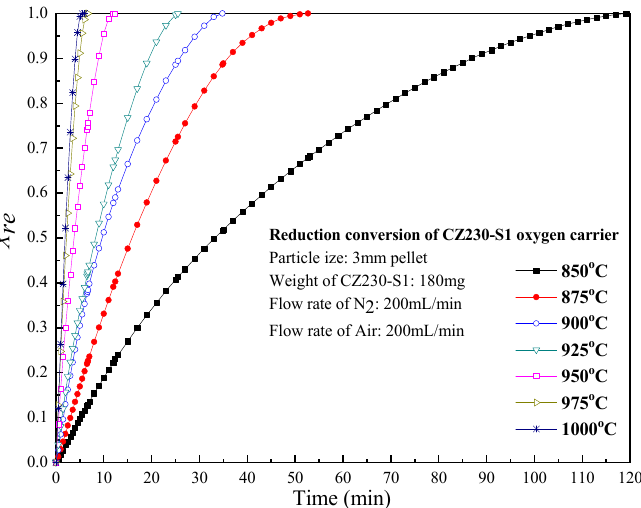
Figure 6. Conversion for oxygen uncoupling of CZ230-S1 in the TGA operated at various temperatures.